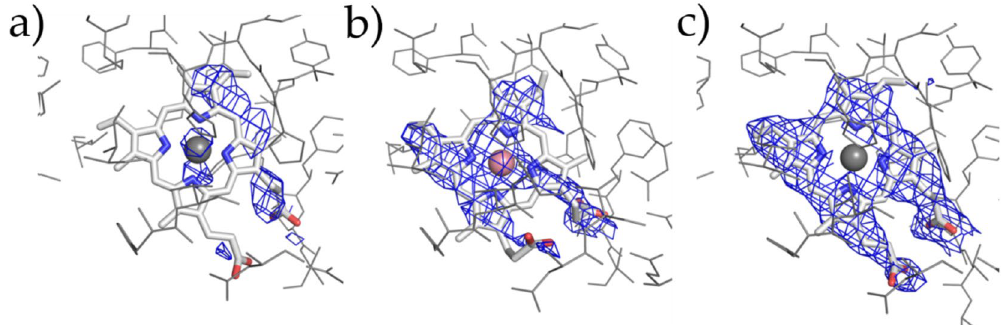
Figure 4. Polder map of heme molecule. Protein residues are shown in gray lines and heme molecules are as gray sticks. ( a – c ) show the polder map contoured at 2.5σ above background for h COX-1 (PDB code 6Y3C), o COX-1 (PDB code 1U67), and o COX-1 (PDB code